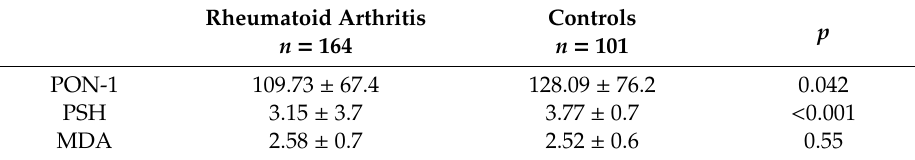
Table 3. Plasma oxidative stress biomarkers in rheumatoid arthritis patients vs. controls.